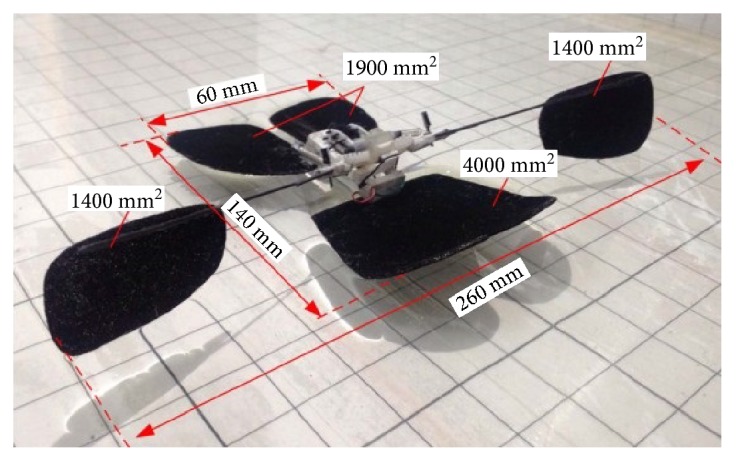
Fabricated water-jumping robot [47].